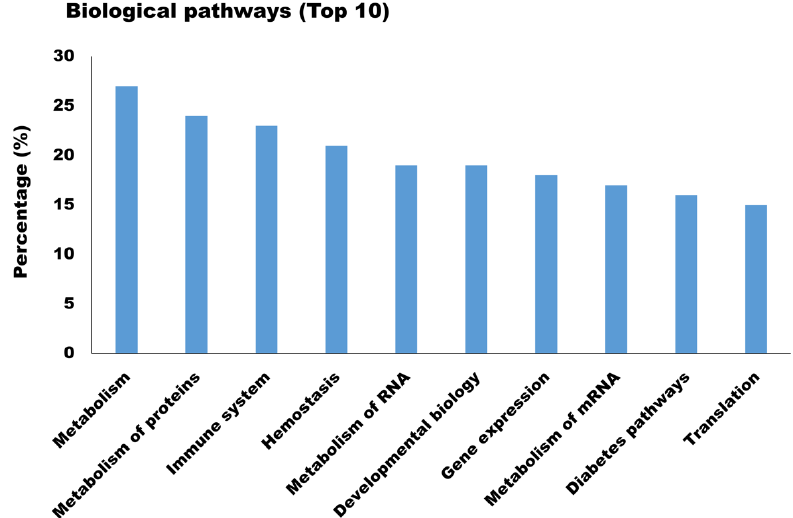
Figure 6. Biological pathway analysis (Top 10) of newly identified proteins in milk